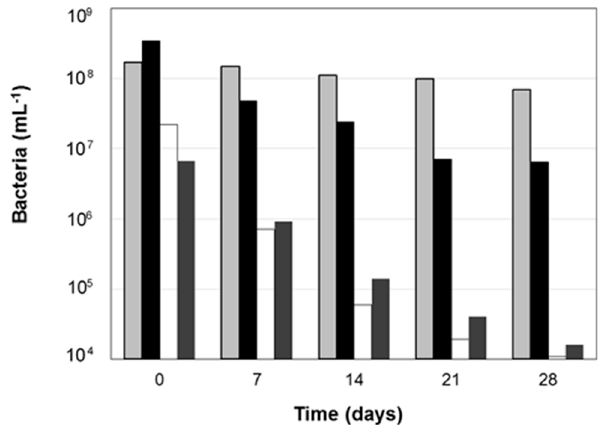
Figure 4. Changes in numbers of viable acidophilic bacteria in the bioreactors: A. ferrooxidans sparged with OFN (black bars) or OFN/CO 2 (light grey bars); A. thiooxidans pH 0.9 (white bars) and 1.2 (dark grey bars).